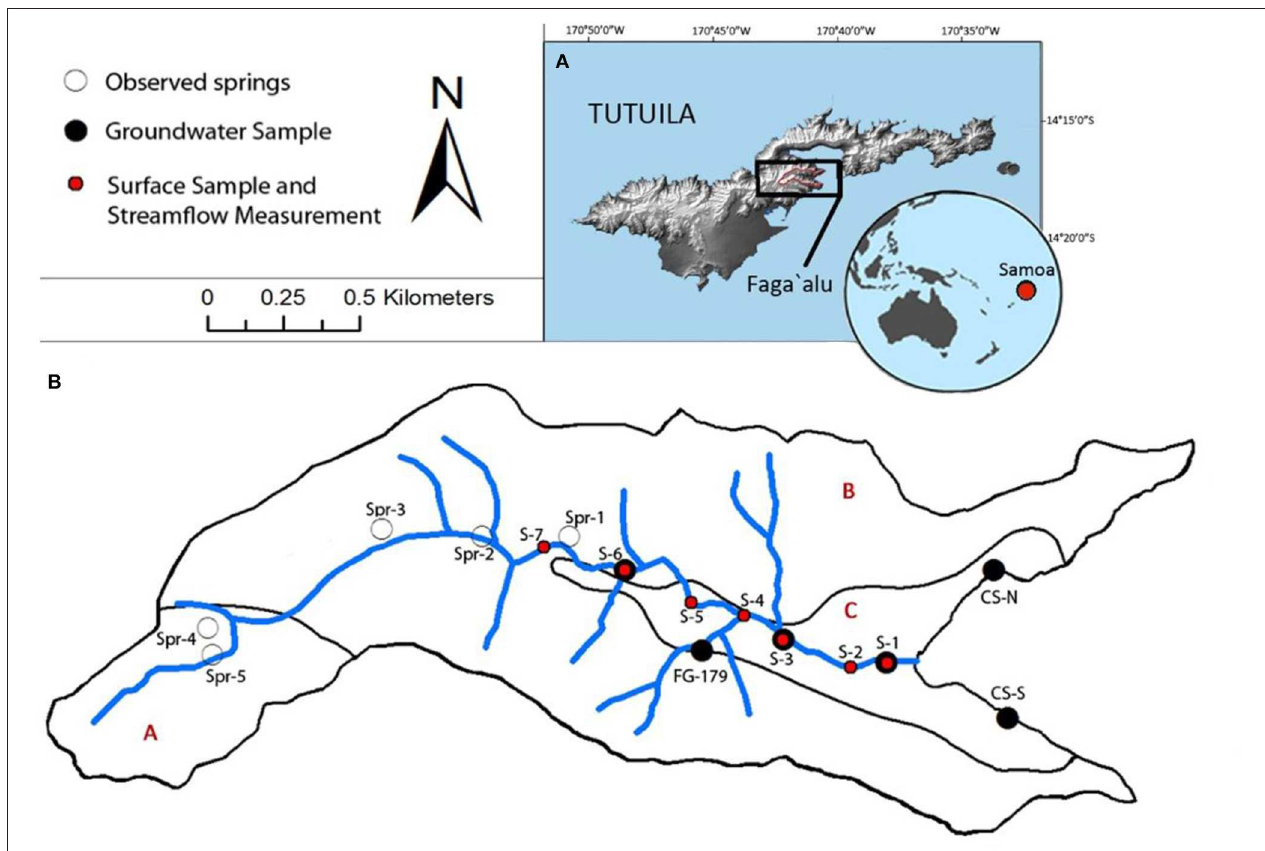
FIGURE 1 | (A) The Faga’alu watershed is located in the central-south sector of Tutuila, American Samoa. (B) Sampling locations are depicted in the detailed map of the watershed, which is divided into primary geologic units: (A) Pago Volcanic Series, intra-caldera, trachyte plugs, and dikes, (B) Pago Volcanic Series, intra-caldera, (C) Beach sand and silty/clay alluvium (Stearns, 1944). Indicated are sampling sites of groundwater (black circles: well FG-179, shallow stream bank and coastal springs sampled using push point samplers 0.8 m below ground surface), stream water (red circles, also locations of seepage runs and 222 Rn measurements), and mountain springs used as observation points for groundwater head level calibration (hollow